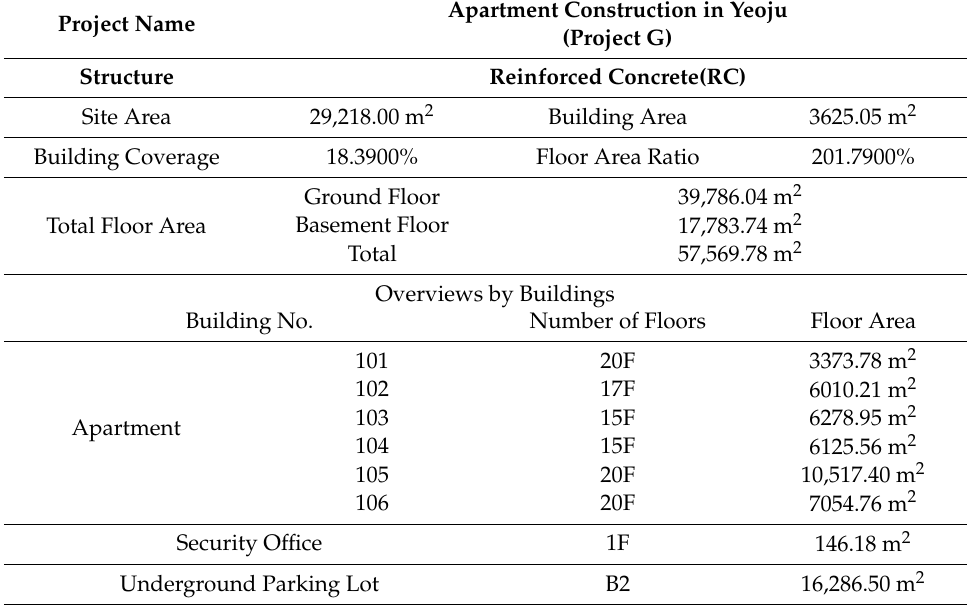
Table A4. Overview of Construction Project G.